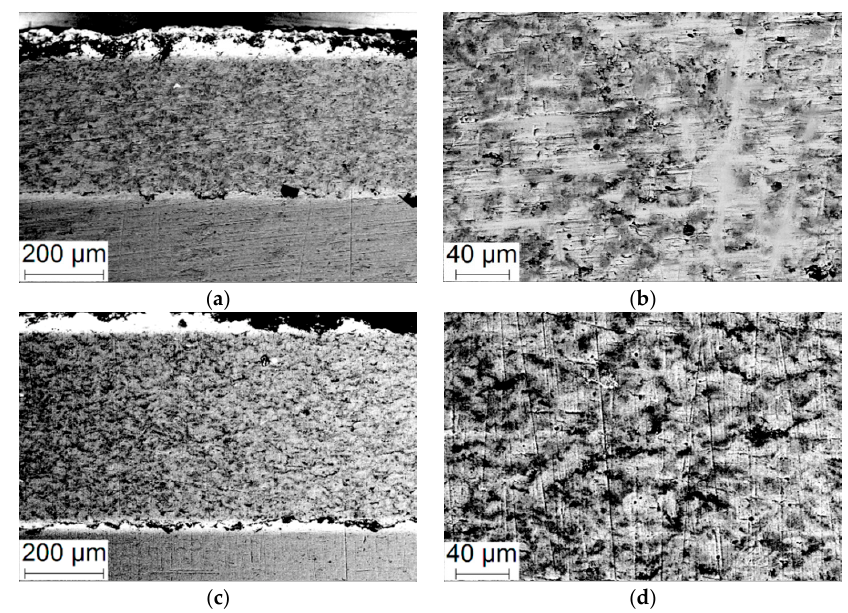
Figure 8. SEM micrographs of the cross sections of specimens produced in regime No. 7 ( a , b ) and No. 8 ( c , d ).